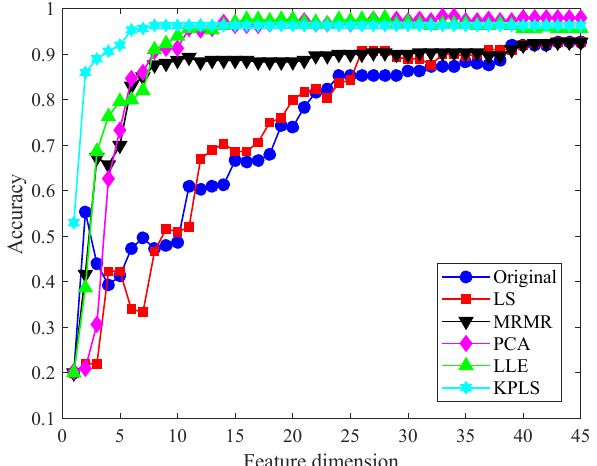
Figure 5. The bearing fault diagnosis accuracy for the KELM with different dimensionality reduc- tion methods.